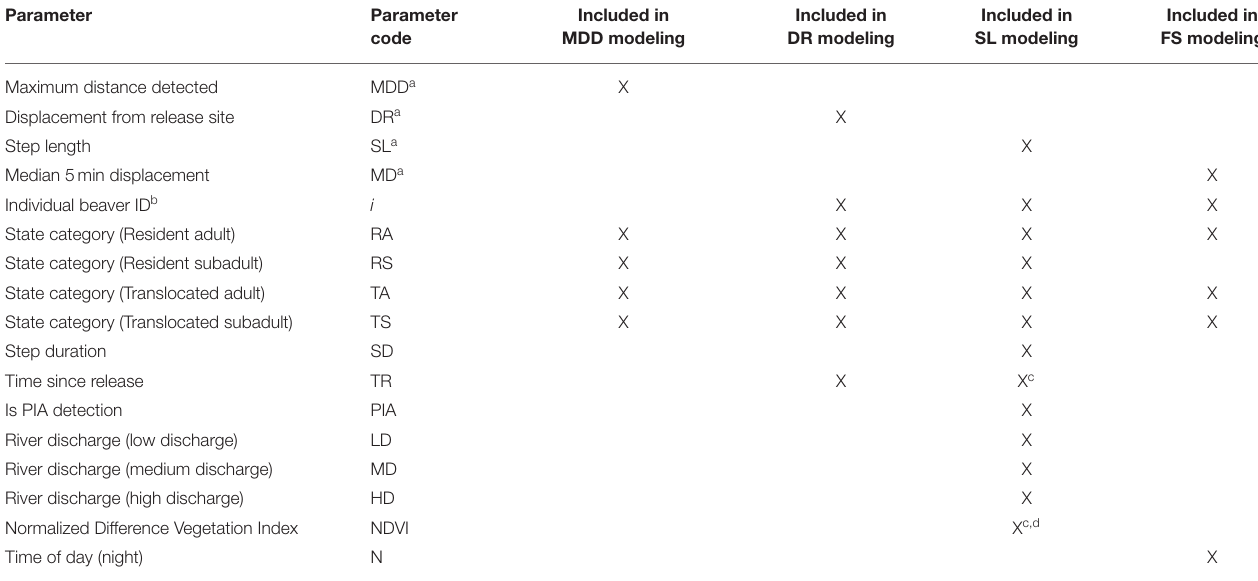
TABLE 2 | Key to parameters included in four models of resident adult, resident subadult, translocated adult, and translocated subadult beaver space use. Parameter Parameter